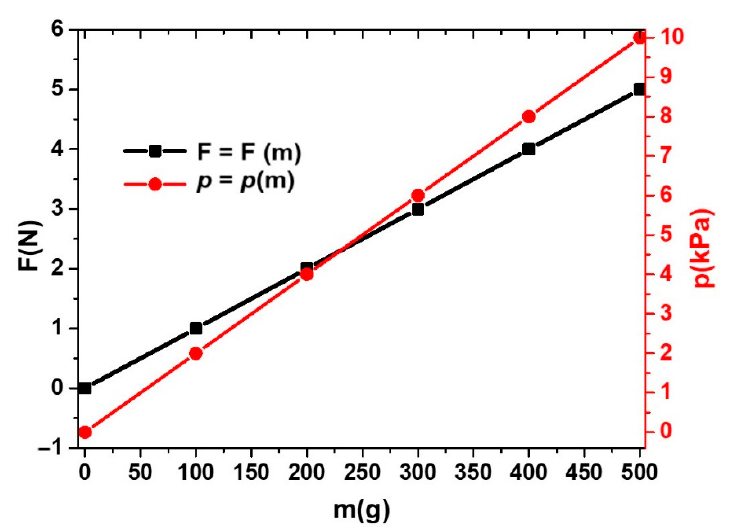
Figure 11. Compression force (F) and compression pressure ( p ) induced on the MTS by the marked masses (m).